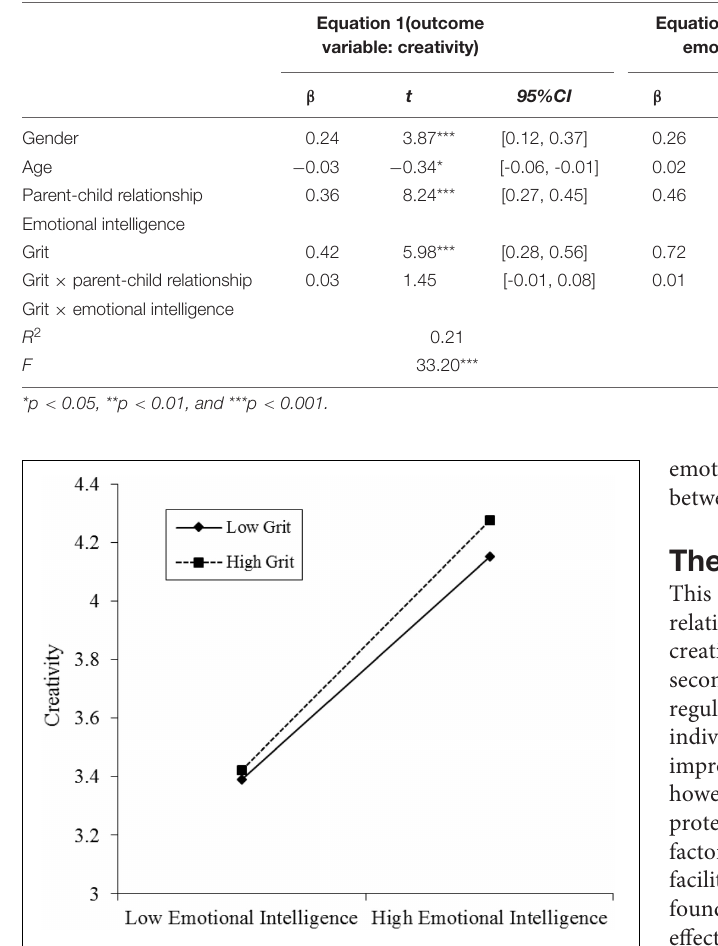
TABLE 2 | Moderated mediation model analysis ( n = 663).